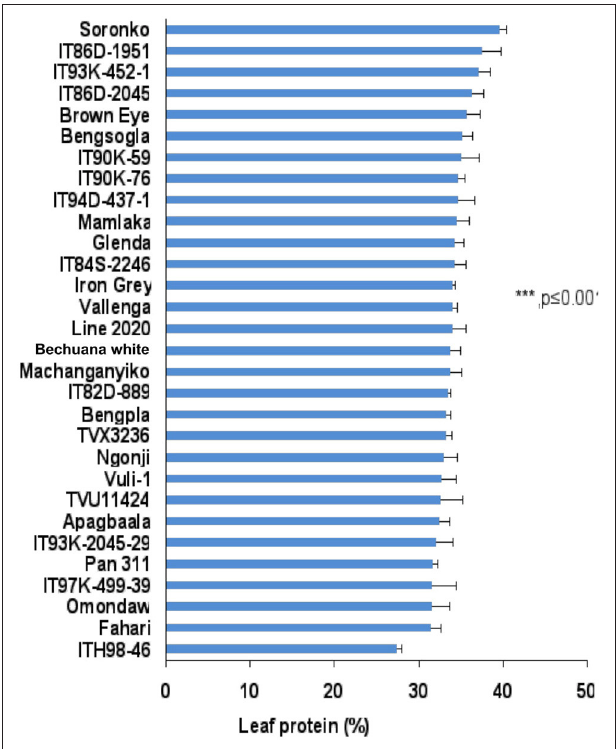
FIGURE 2 | Total leaf protein of 30 cowpea varieties at Wa, Ghana in 2005.